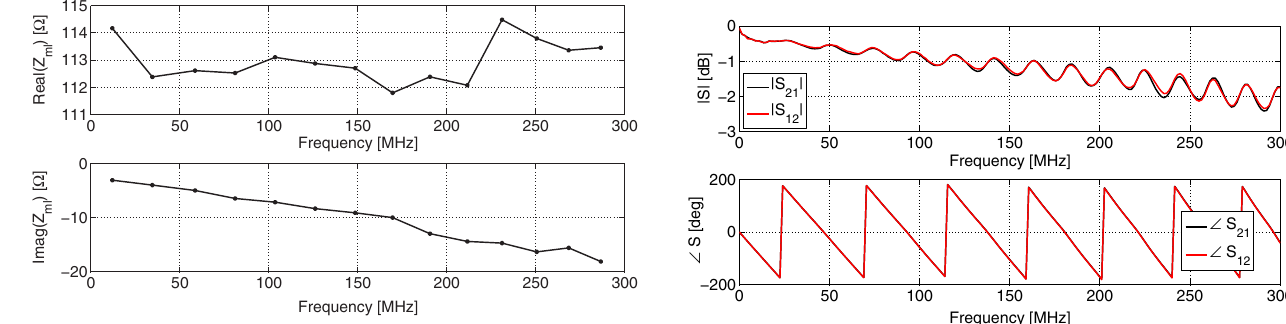
FIG. 12. Modulus and phase of S 21 ml and S 12 ml , normalized to 100 (cid:1) impedance.